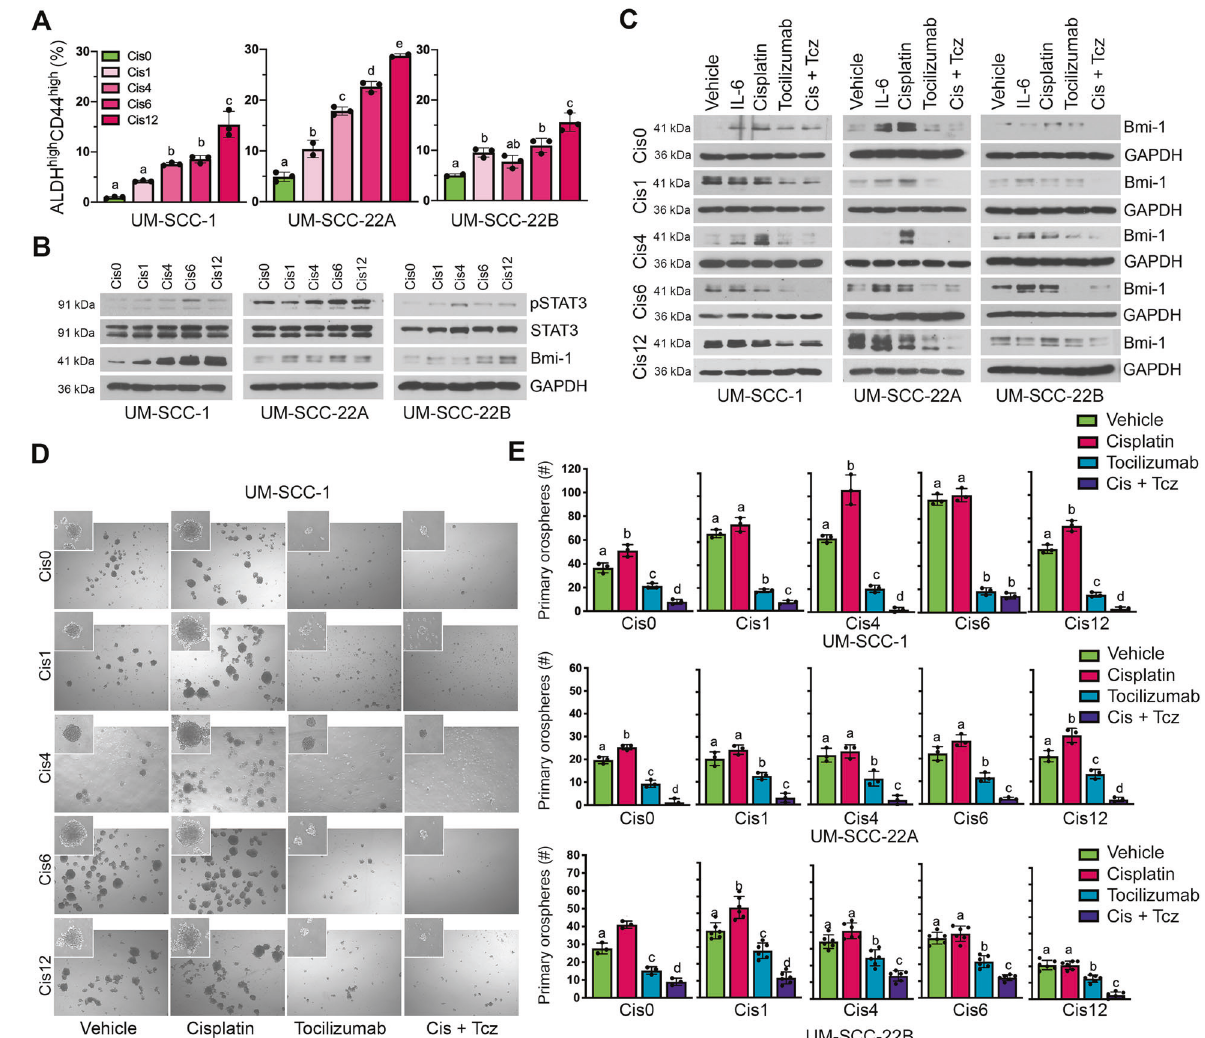
Fig. 5 Tocilizumab decreases the CSC fraction and the self-renewal of Cisplatin-resistant HNSCC cells. A Bar graphs depicting the CSC fraction (ALDH high CD44 high cells) in Cisplatin-naive and Cisplatin-resistant variants of UM-SCC-1, UM-SCC-22A, and UM-SCC-22B cells, as determined by fl ow cytometry. Graphs display mean ± SD ( n = 3) and signi fi cance denoted by different lowercase letters at p < 0.05. B Western blottings showing baseline expression of phosphorylated STAT3, total STAT3, and Bmi-1 expression in Cisplatin-naive and Cisplatin-resistant HNSCC cell line variants. C Western blot analysis of Bmi-1 expression after treatment with rhIL-6 (20 ng/ml), Cisplatin (1 µm), and/or Tocilizumab (0.1 µM). D Representative images (×40) of Cisplatin-naive and Cisplatin-resistant UM-SCC-1 primary orospheres on day 8 after treatment with Cisplatin (1 µM) and/or Tocilizumab (0.1 µM). Cells were treated the day after seeding in ultra-low attachment plates. Inserts at ×100 magni fi cation. E Bar graphs depicting number (mean ± SD) of primary orospheres per well, from three wells per experimental condition. Different lowercase letters indicate statistical signi fi cance at p <